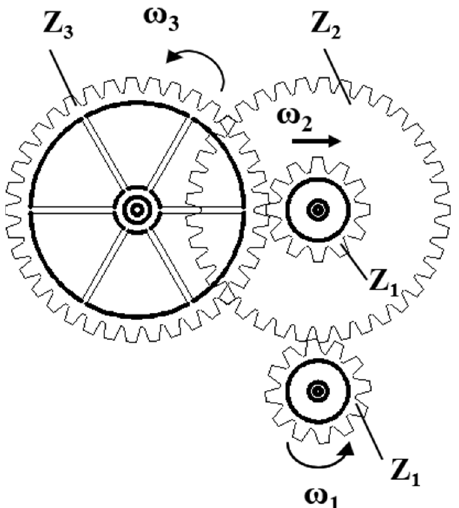
Figure 4. Power conversion diagram.